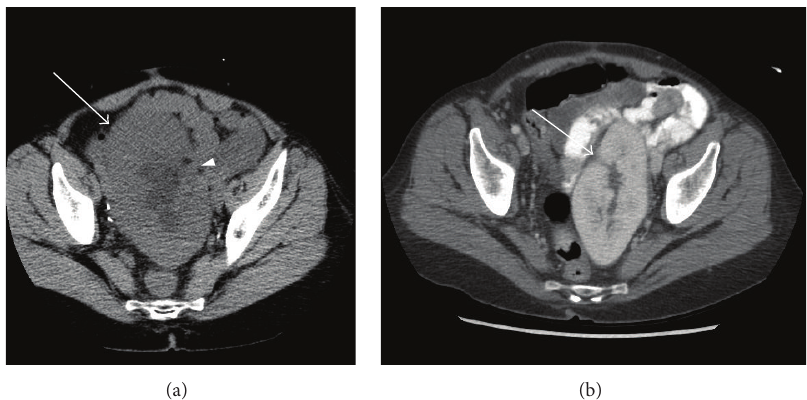
Figure 1: Noncontrast axial CT image through the pelvis (a) showed an enlarged left lower quadrant renal allograft (arrow) measuring 14.4 × 7.6 cm with moderate hydronephrosis and trace pelvic free fluid. Note that the hilum is directed laterally (arrowhead). This was a clear change in orientation when compared to a contrast enhanced CT scan obtained a year and half earlier (b) where the hilum was directed anteromedially (arrow).